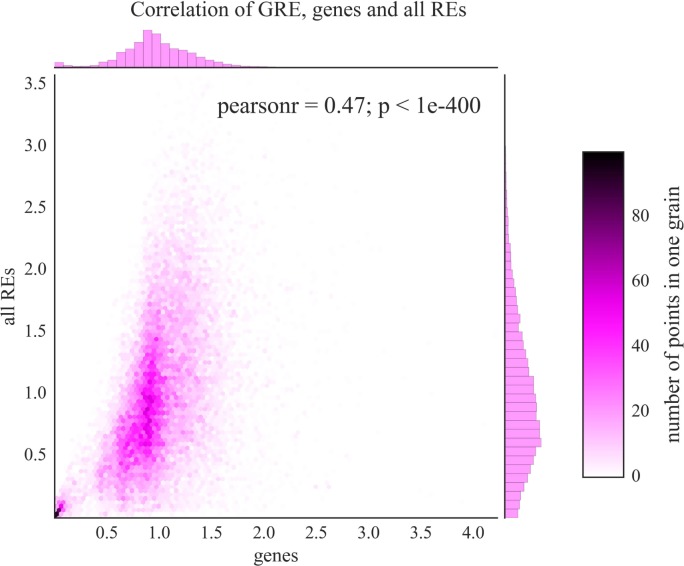
Comparison of GRE scores (axis of ordinates) and GTE scores (abscissa axis) for known human genes. Color scale is given to show densities of incidences on the plot. Each dot represents a single gene. Pearson r—Pearson correlation coefficient; p—Pearson p-value.